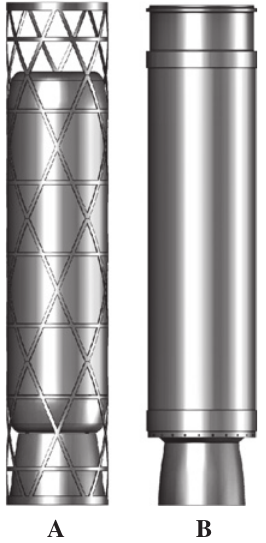
Figure 1 A conceptual design of a stiffened solid propellant motor case using a lattice structure (A) and normal multipartite solid propellant motor case